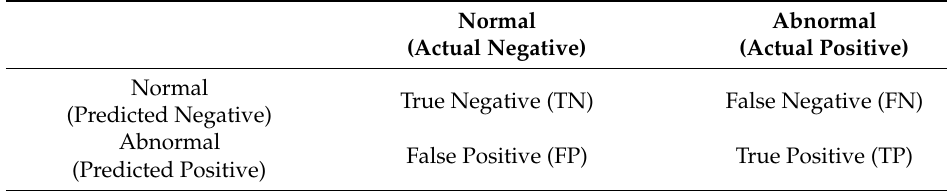
Table 2. Confusion matrix.